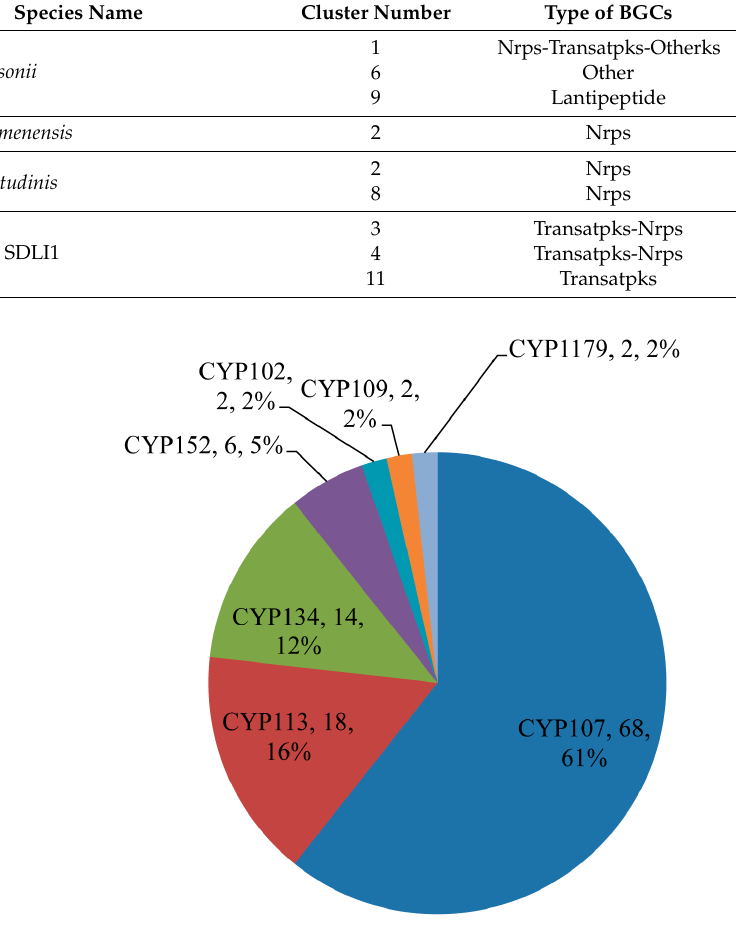
Figure 8. Comparative analysis of P450 families involved in secondary metabolite biosynthesis.